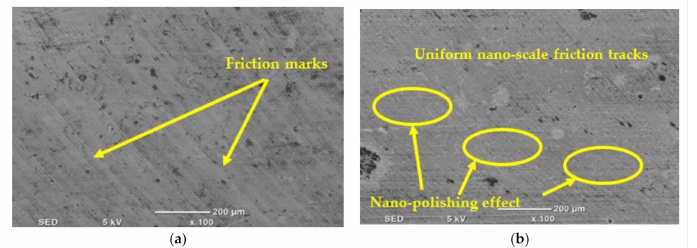
Figure 14. Comparison in SEM images between ( a ) MQL and ( b ) MQL + Al 2 O 3 nanoparticles cooling conditions at cutting speed = 30 m/min and feed rate = 50